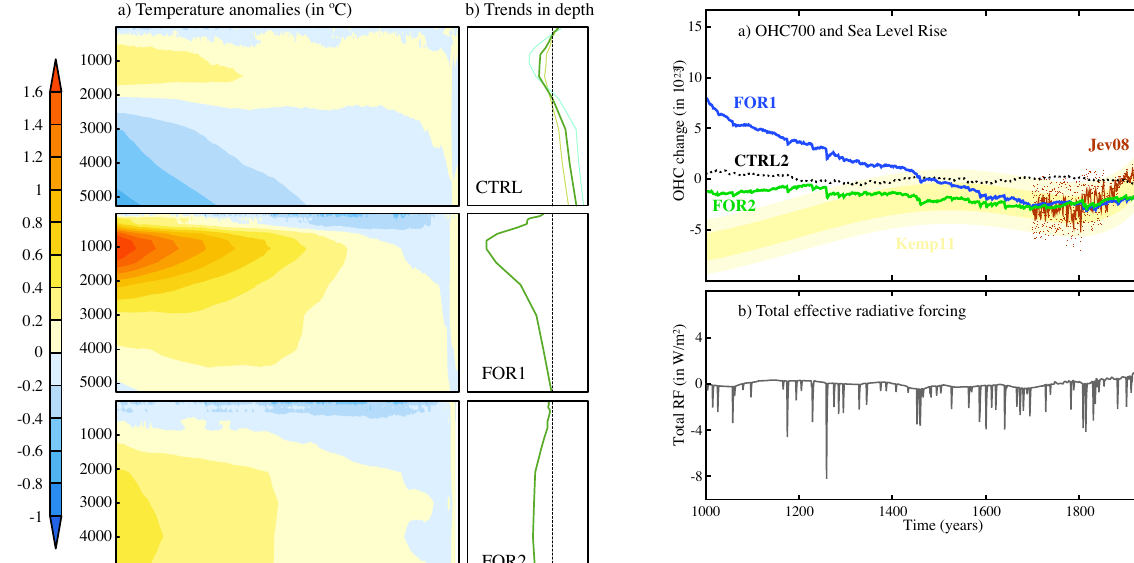
Fig. 5. (a) Anomalies of the simulated global OHC700 (in 10 23 J) and the reconstructed SL variations wrt the period 1960–1990. SL curves correspond to observations from tide gauges since 1700AD (brown line; Jevrejeva et al., 2008) and to an idealized summary curve for the last millennium from proxy reconstructions with salt- marsh sediments in North Carolina; (b) Effective radiative forcing applied to the forced simulations (in Wm − 2